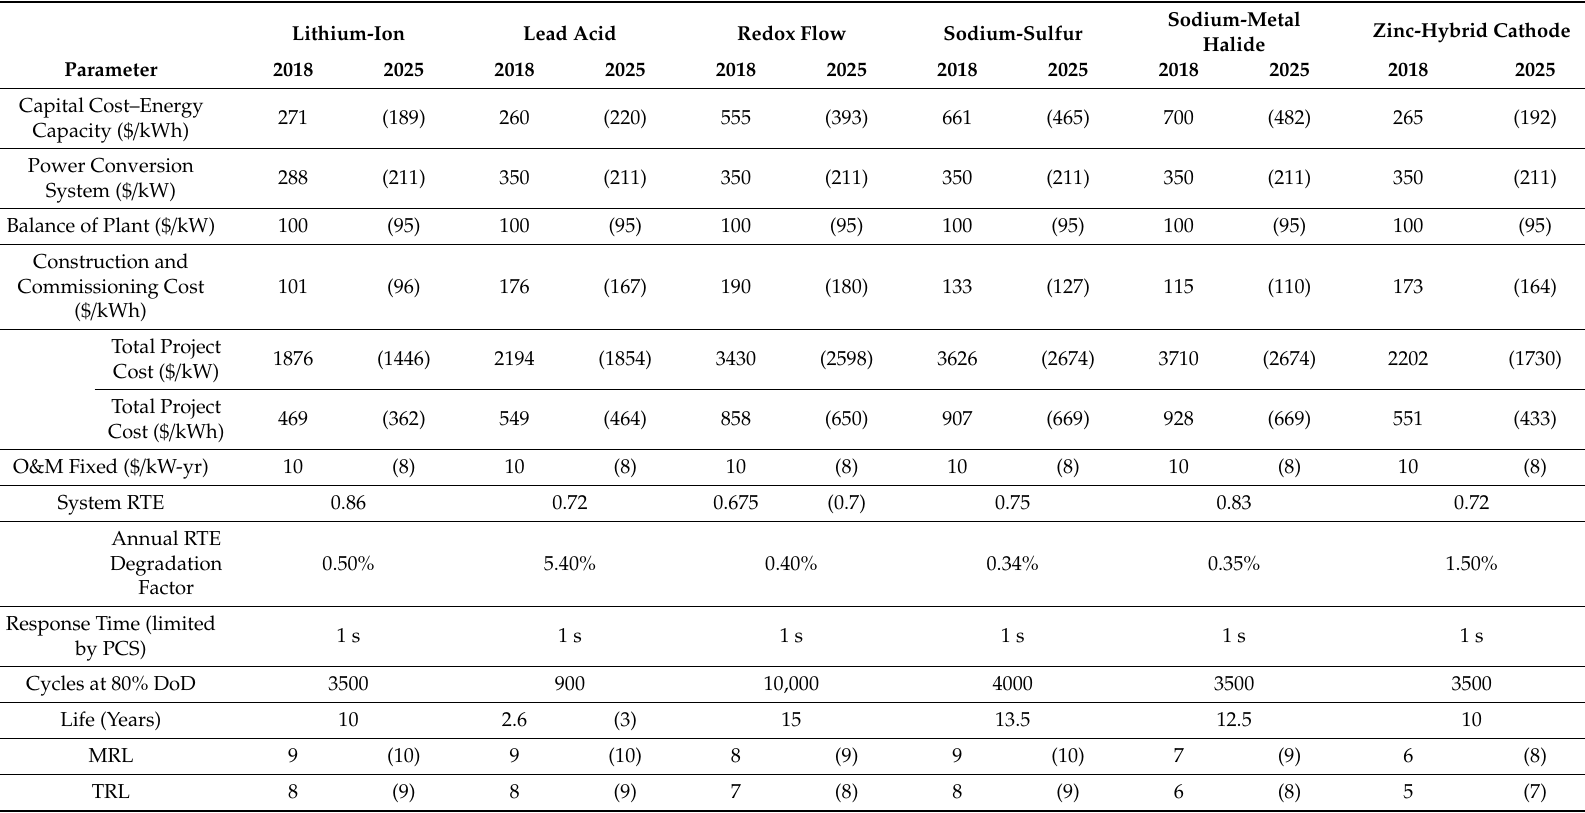
Table 7. Summary of compiled 2018 findings and 2025 predictions for cost and parameter ranges by technology type—BESS (a)(b)